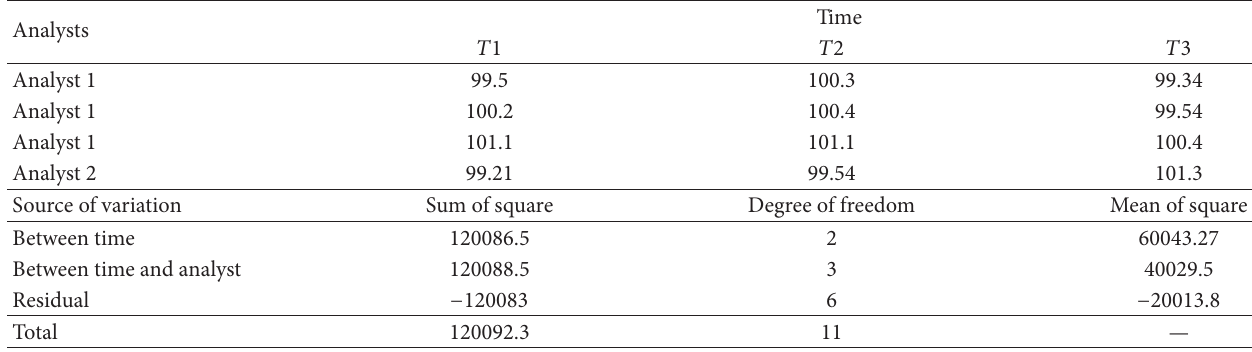
T 3: Intraday precision study for TE.